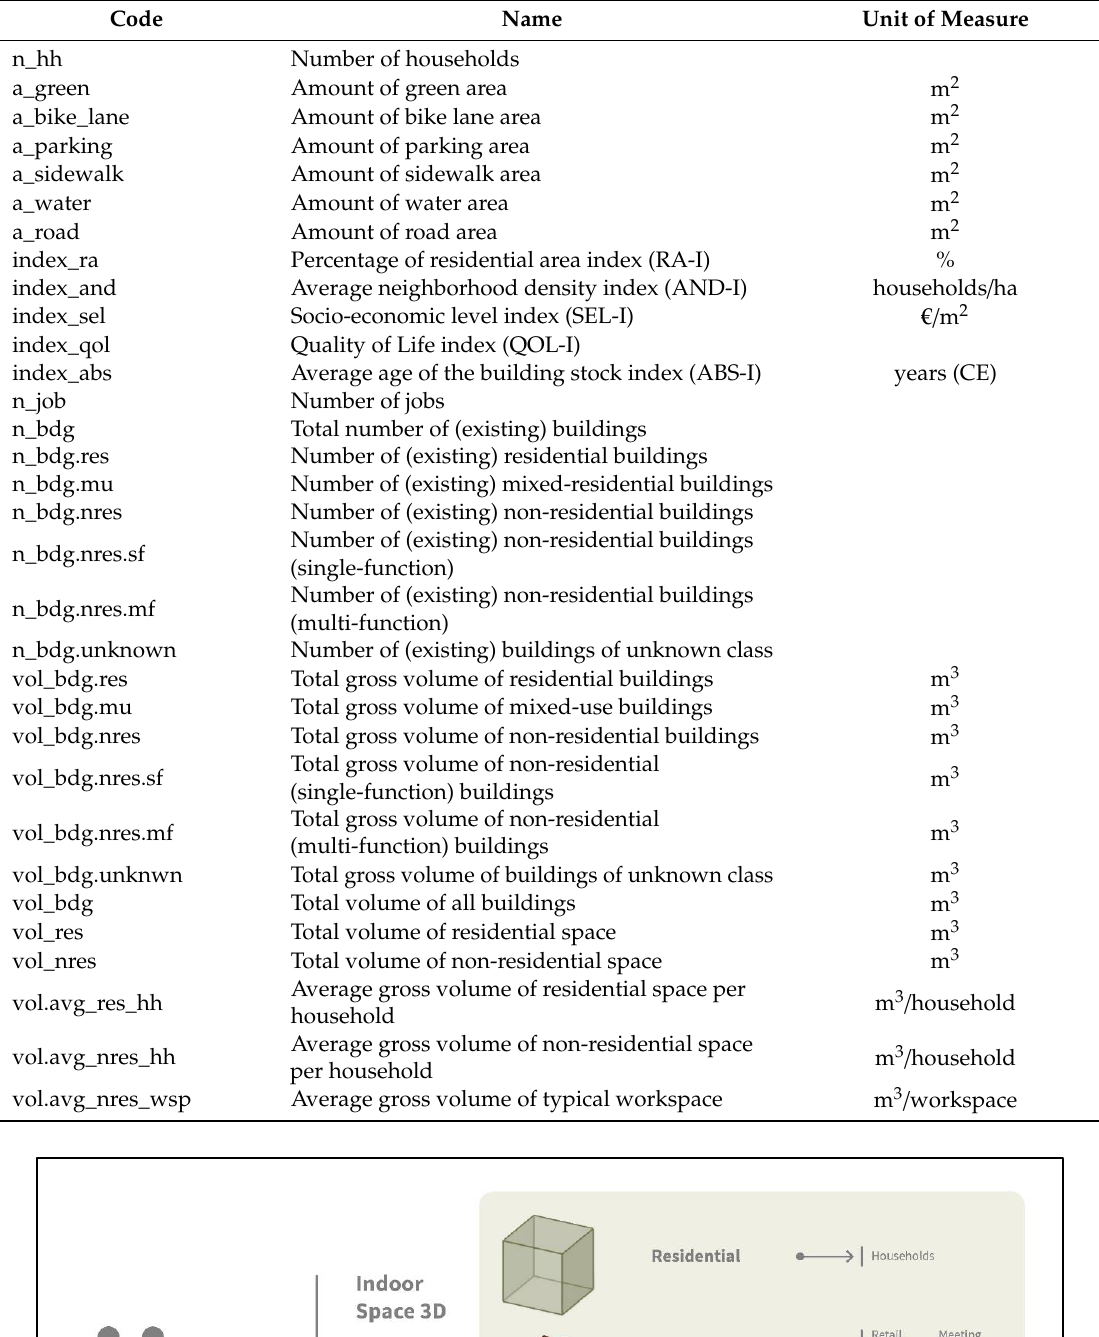
Table 4. List of zonal parameters computed from the 3D city model and other datasets.